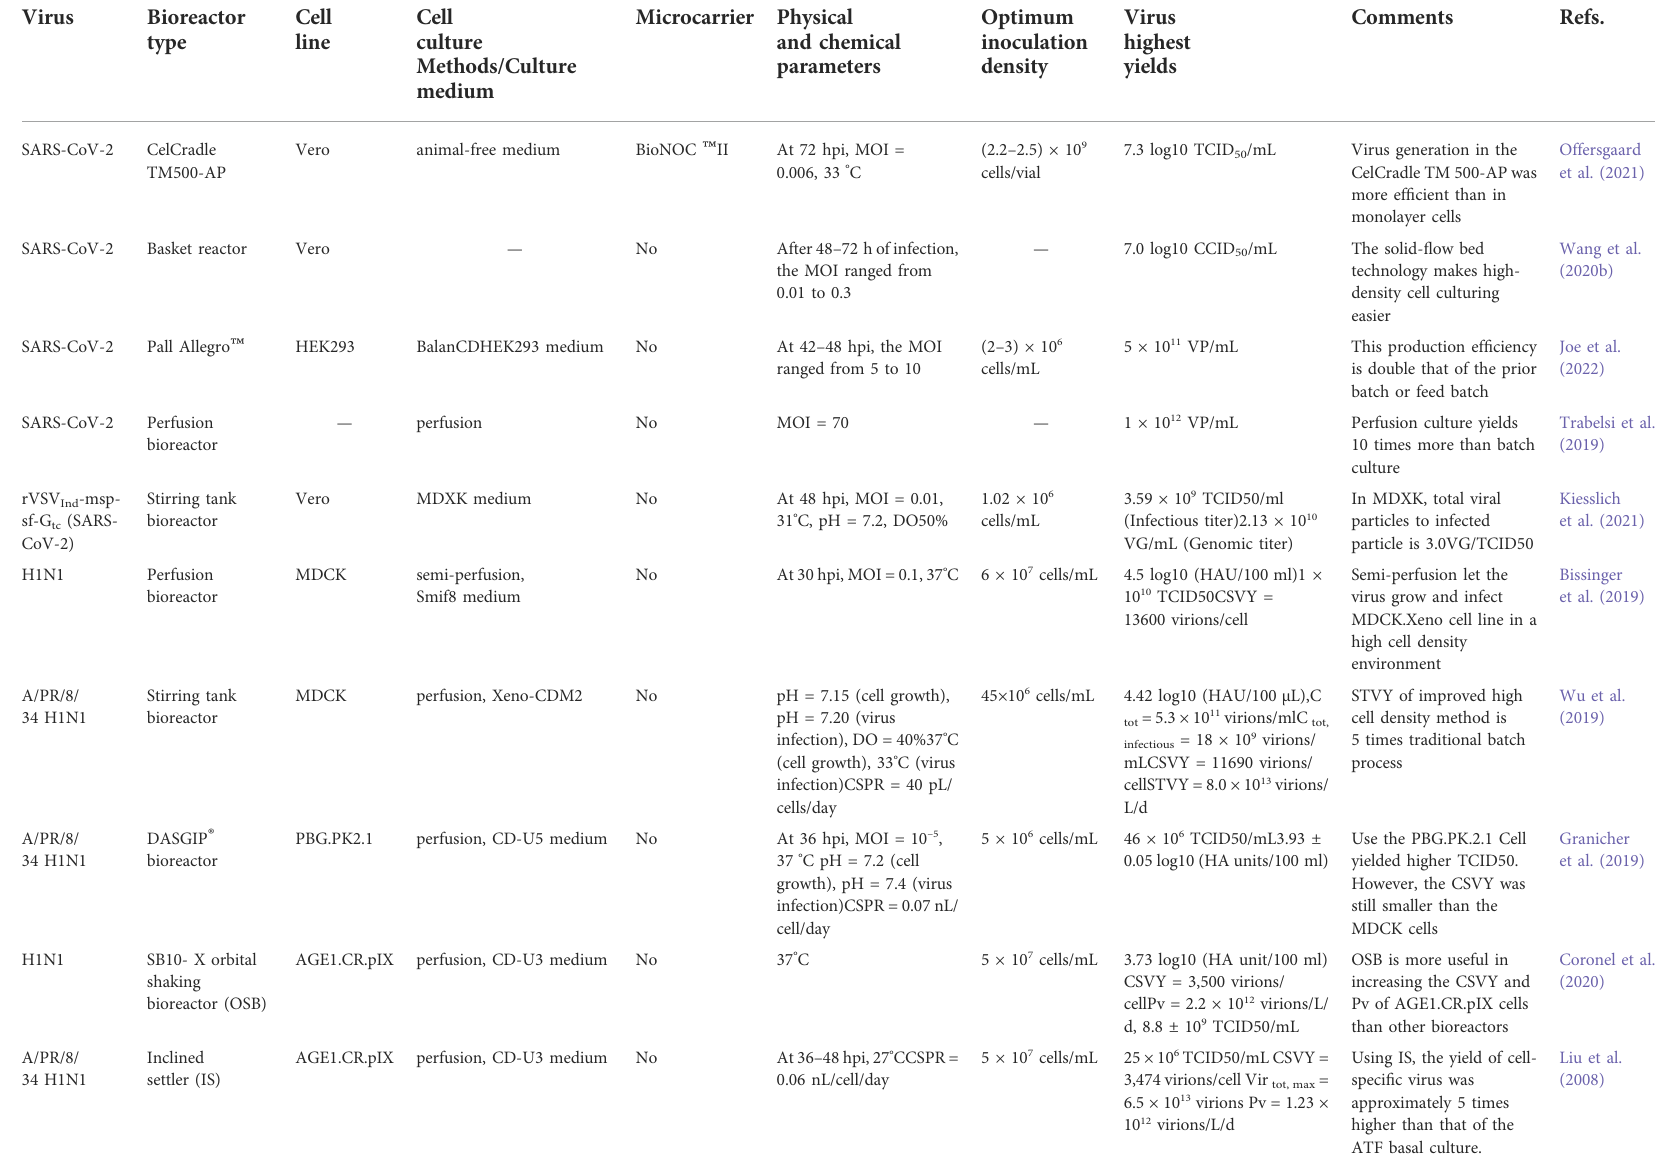
TABLE 2 Overview of virus production process in the cell culture reported in the